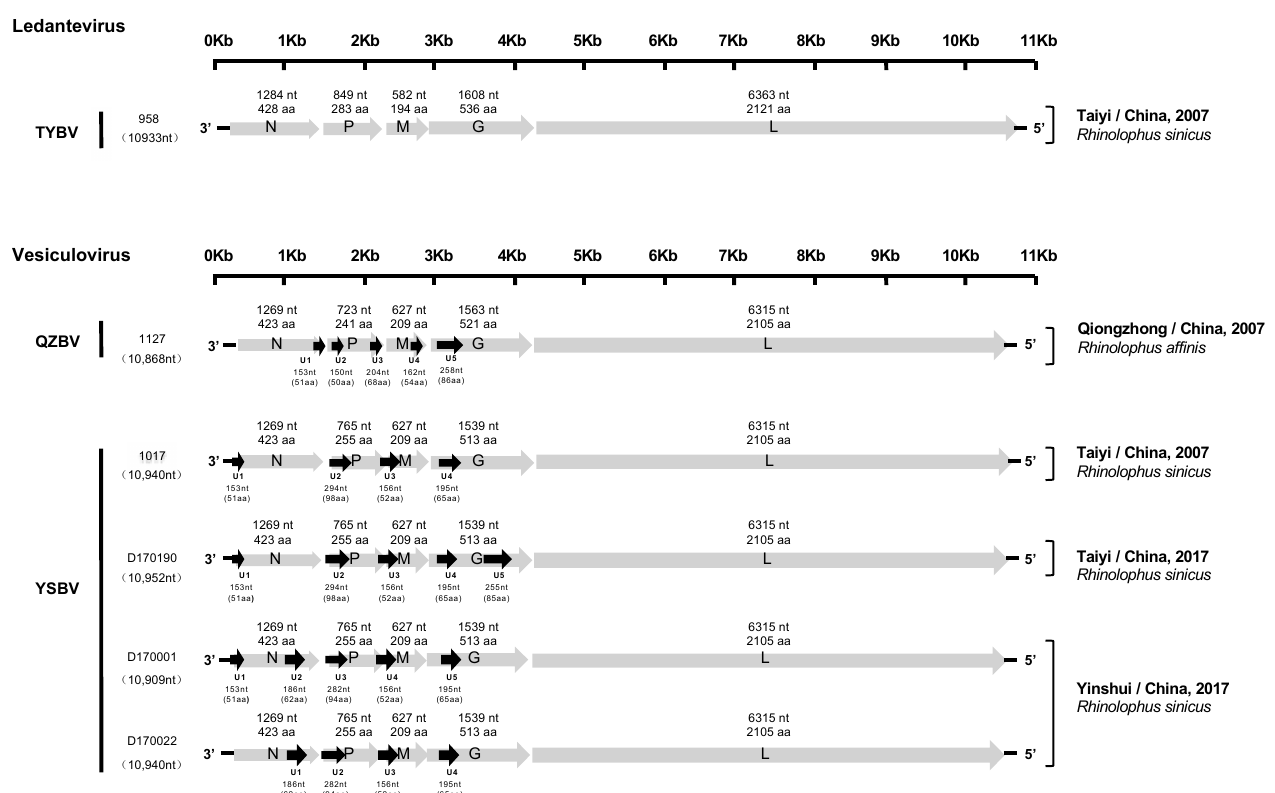
Figure 2. Schematic genomic organization of the six Chinese bat rhabdoviruses. The grey arrows represent the five canonical open reading frames (ORFs) (N, P, M, G, and L), and the black arrows indicate the position of the putative additional ORFs. The nucleotide and amino acid lengths of each ORF are indicated.